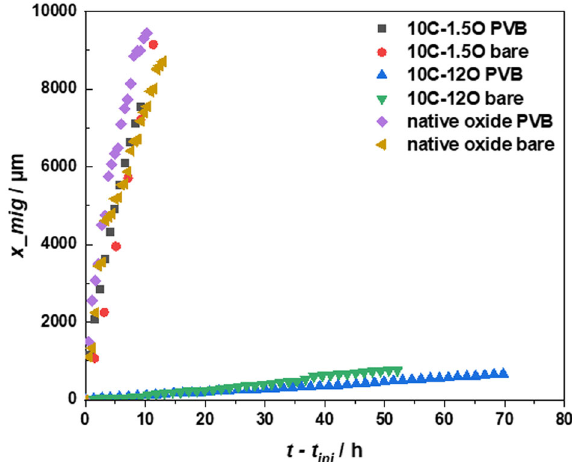
Fig. 6 Position of migration front vs. time plot for different samples. Position of migration front ( x_mig ) plotted as a function of time for the bare and PVB-coated samples.